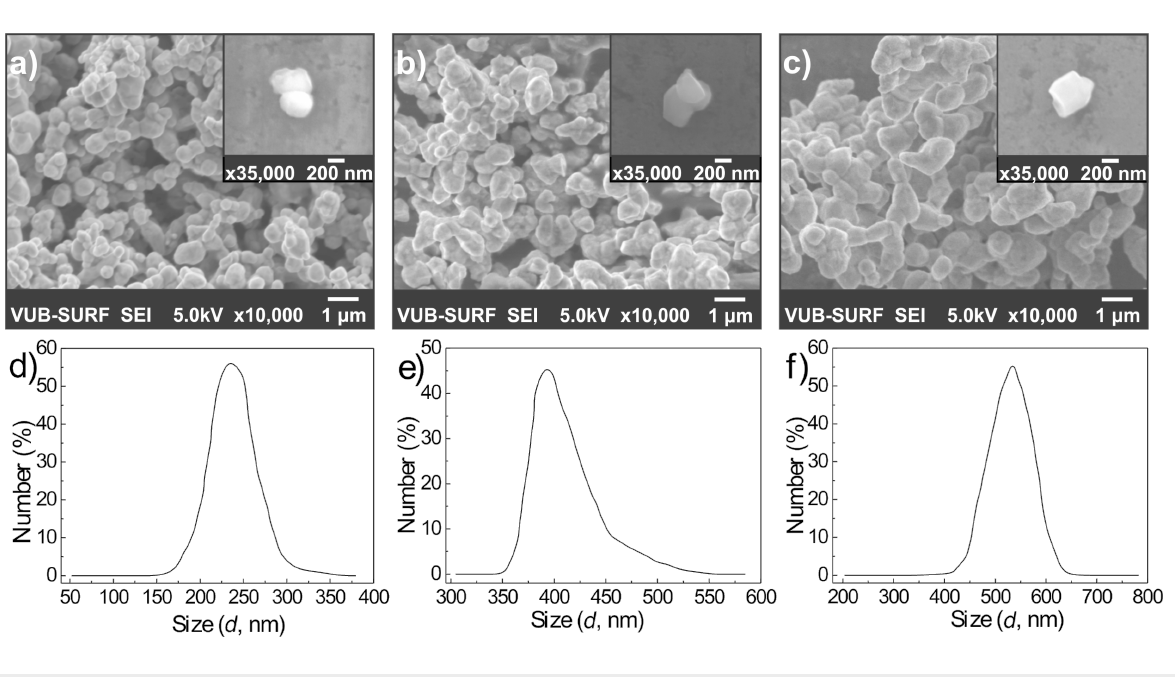
Figure 1: Field emission scanning electron microscopy (a–c) and atomic force microscopy images (insets in a–c) and particle size (diameter) distribu- tions (d–f) obtained by dynamic light scattering of SFMO-4 (a,d), SFMO-6 (b,e), SFMO-9 (c,f) powder samples. The samples were annealed in the polythermal regime over a 770–1220 K temperature range, at 2 K/min, in a continuous stream of 5% H 2 /Ar gas